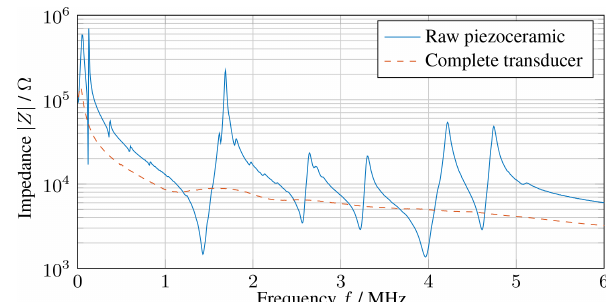
Figure 3. Step response and impulse response of the